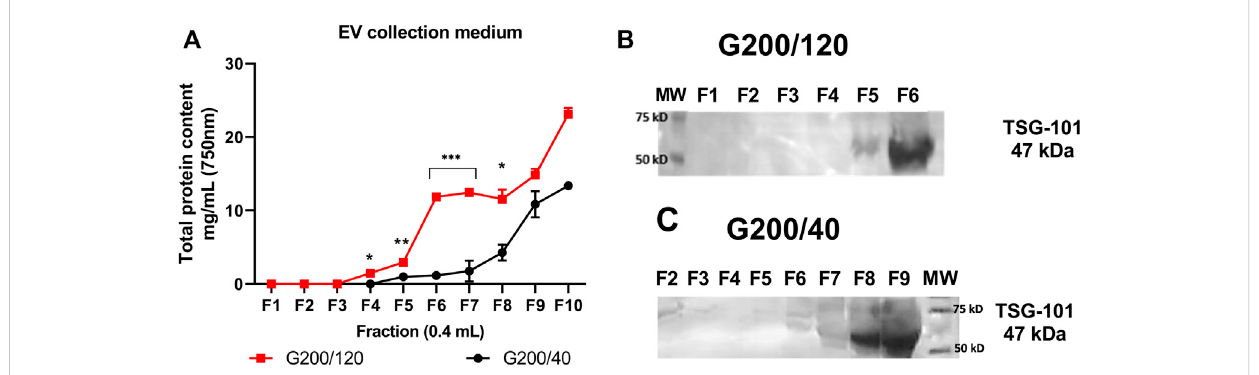
FIGURE 2 Proteinpro fi le andTSG-101 expression inEVcollectionmedium.Twoconsecutive fractions werecollected tocomplete400 µLelution volumeper fraction. Each combined fraction was concentrated in a centrifugal rotary evaporator at 4 ° C overnight and resuspended in 200 µL. (A) Protein elution pro fi lefortheEV-collectionmedium. (B) WesternblotanalysisfortheTSG-101expressionofthecollectedfractionsfromG200/120columnand (C) from G200/40 column. Statistical differences were observed between fractions F4 to F8 in the total protein content from G200/120 versus G200/40 columns. (*) p < 0.05, (**) p < 0.01, (***) p < 0.005. Images represent TSG-101 expression obtained from RIPA-lysate fractions. MW: molecular weight ladder. n = 6 for each column.